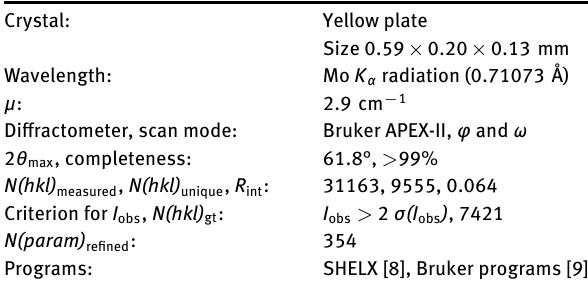
Table 1: Data collection and handling.